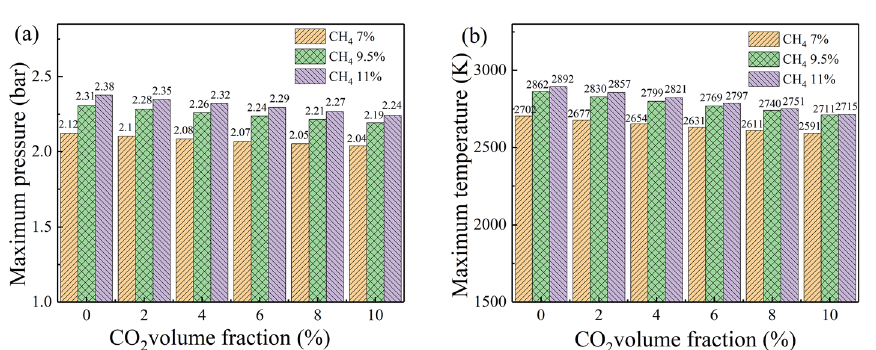
Figure 2. Variation of explosion pressure and temperature with CO 2 volume fraction under different methane volume fractions: ( a ) explosion pressure and ( b ) explosion